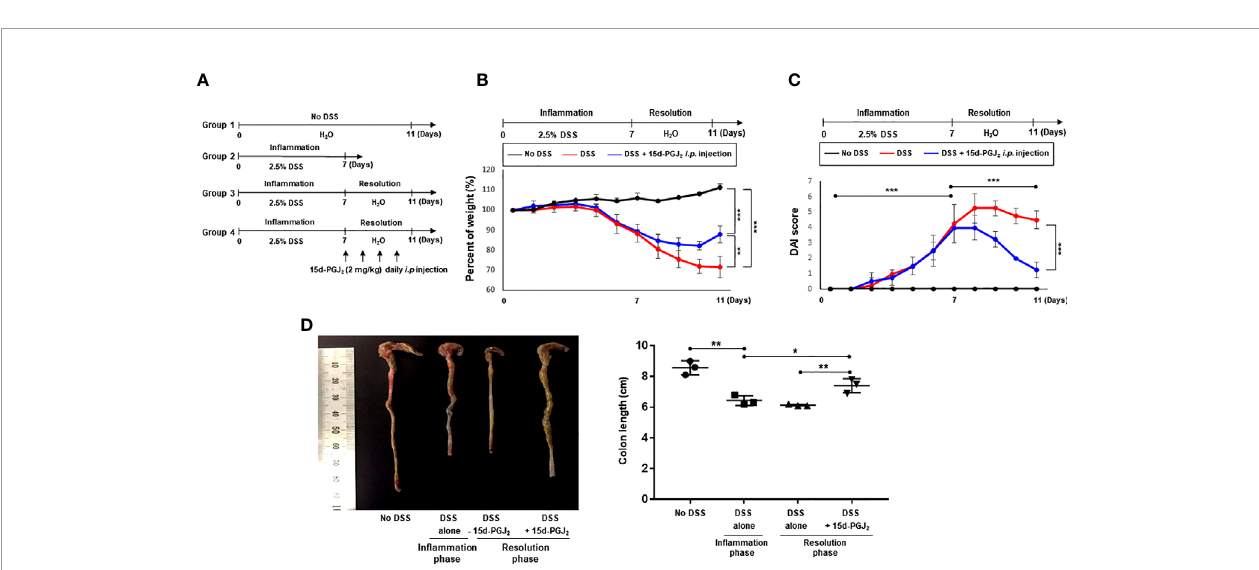
FIGURE 3 | 15d-PGJ 2 ameliorated pathological symptoms for resolution of intestinal in fl ammation. (A) Mice were administrated with drinking water containing 2.5% DSS for 7 days, followed by normal drinking water for 4 days. 15d-PGJ 2 (2 mg/kg) or vehicle was intraperitoneally injected to mice every day during resolution phase of in fl ammation. (B) The change of body weight was monitored and (C) DAI was scored. (D) On day 7 (in fl ammation phase) and day 11 (resolution phase), the colon length was determined, compared with no DSS group. All data represent mean ± S.D. (n=3). * p < 0.05, ** p < 0.01, and *** p <